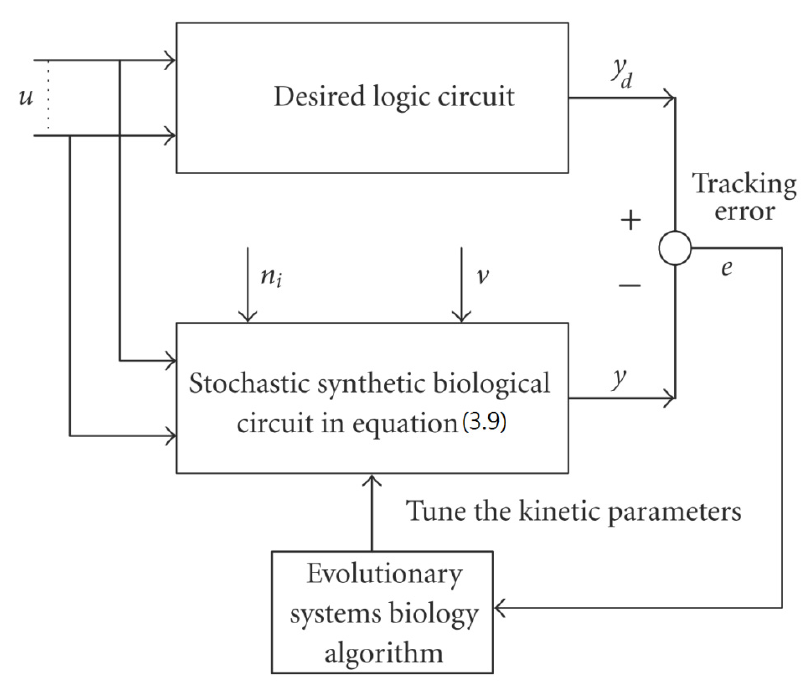
Figure 9. Block diagram of the optimal tracking scheme for synthetic biological circuit design using an evolutionary systems biology algorithm. Based on a network algorithm mimicking natural selection in an evolutionary process, the design parameters k of a synthetic biological circuit are tuned to minimize the tracking error between the